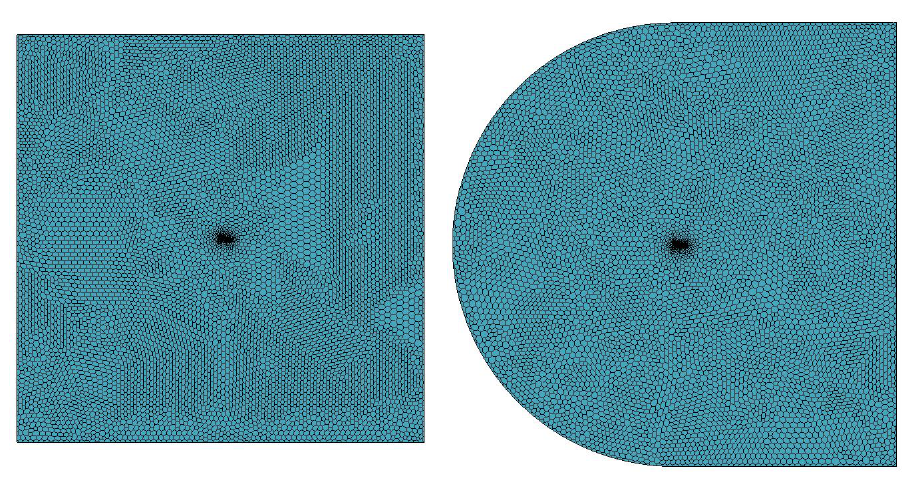
Figure 7. Box ( left ) vs. Bullet ( right ) Domains.